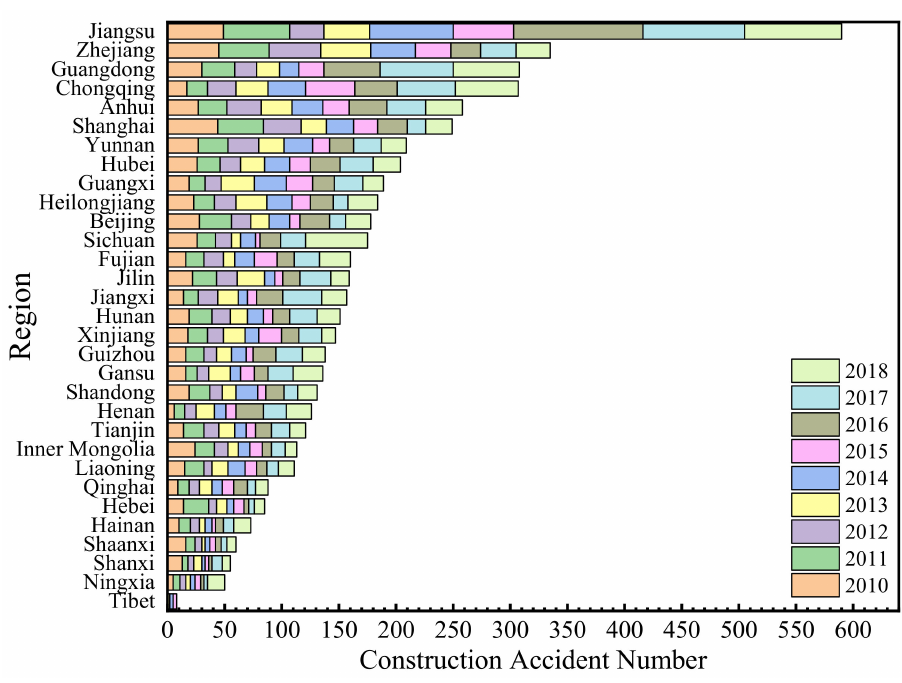
Figure 3. Total construction accidents in 31 regions of China.